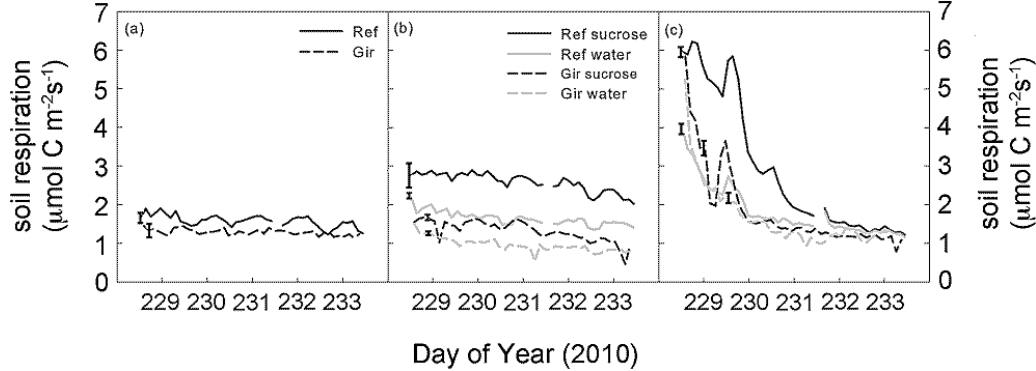
Fig. 6. Girdled–reference comparison experiment respiration response for (a) untreated chambers, (b) mineral soil surface applications, and (c) litter surface application. Error bars represent ± 1SE (within-treatment mean over all sample timepoints).